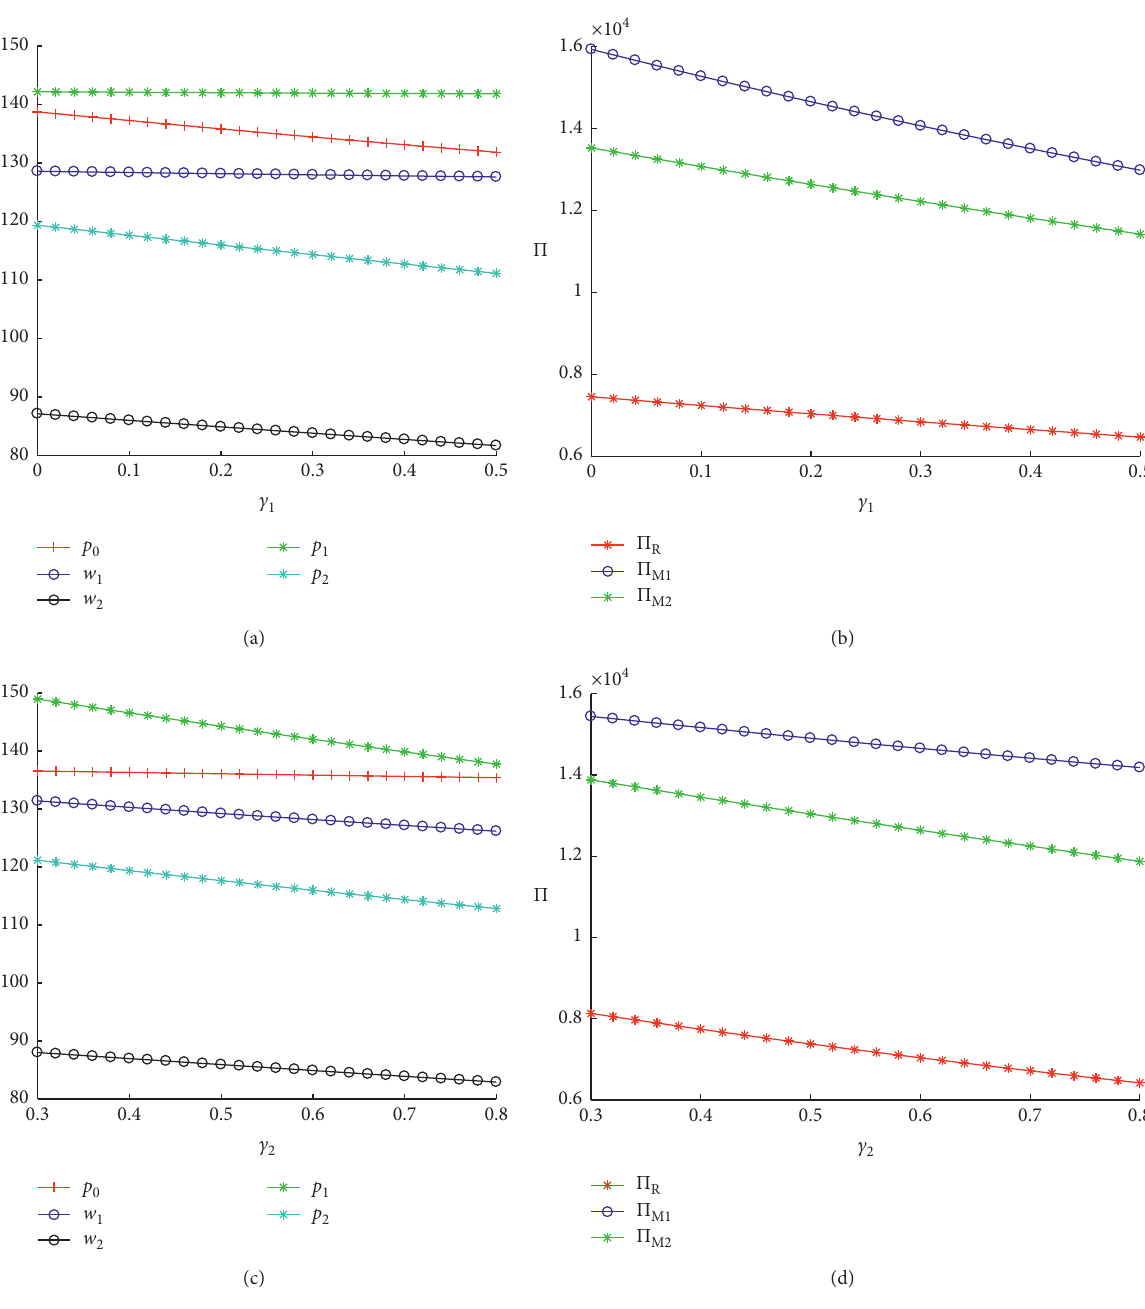
Figure 4: Influence of c ( i � 1 , 2 ) on the price and profit functions in the M1-M2 Bertrand i